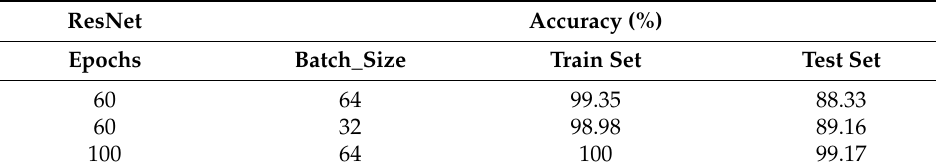
Table 3. Comparative results for the ResNet models.